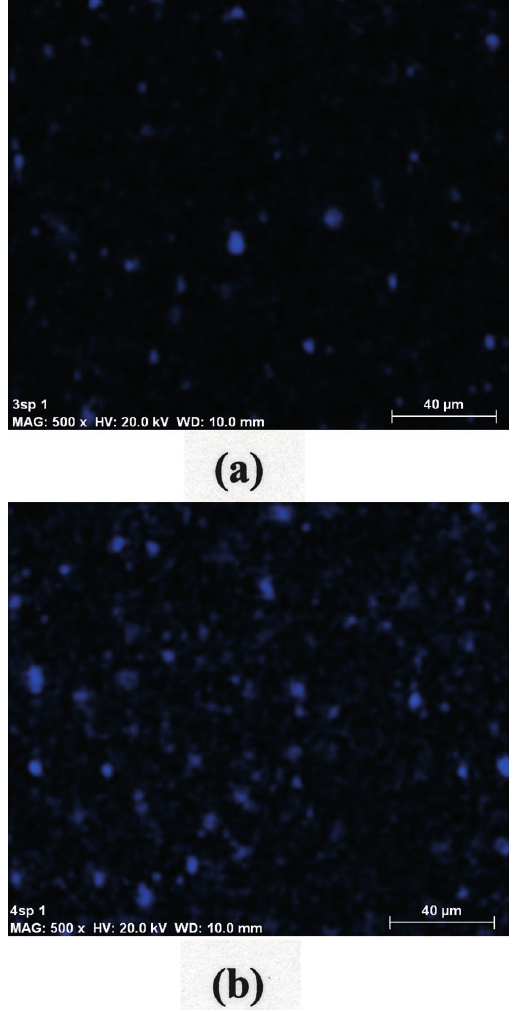
Figure 2: Typical EDX test micrographs showing the spread of Ca element on the surfaces of tapes: a – sample A, b – sample E.